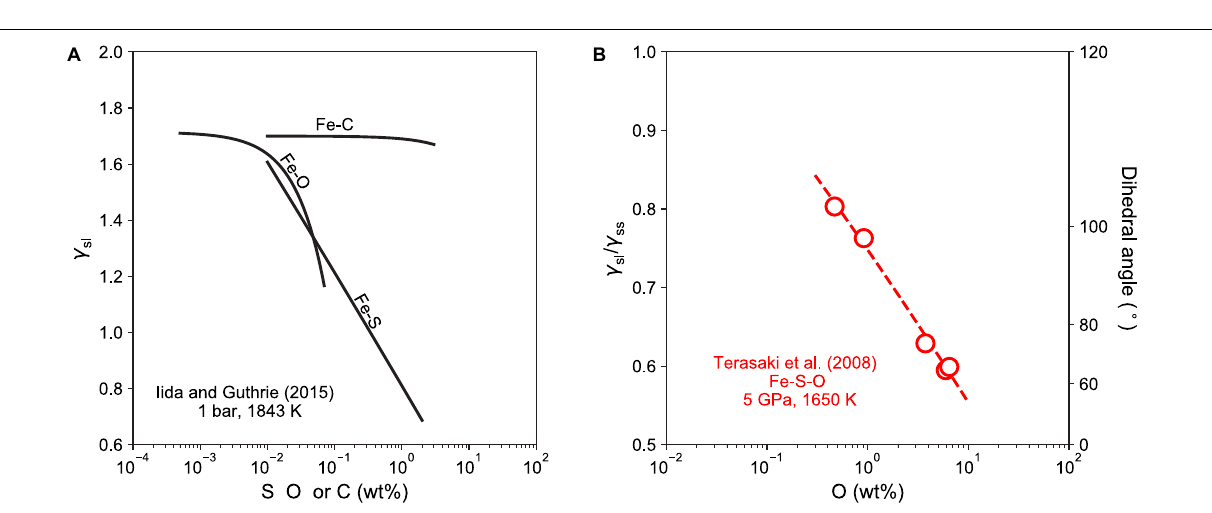
FIGURE 6 | (A) Surface tension of iron-rich melt on aluminum oxide surface as a function of the concentration of lighter alloying element at 1 bar and 1843 K (Halden and Kingery, 1955; Iida and Guthrie, 2015). (B) Ratio of surface tensions and dihedral angles of iron-rich melt in mantle silicate as a function of the concentration of lighter alloying element at 5 GPa and 1650 K (Terasaki et al.,